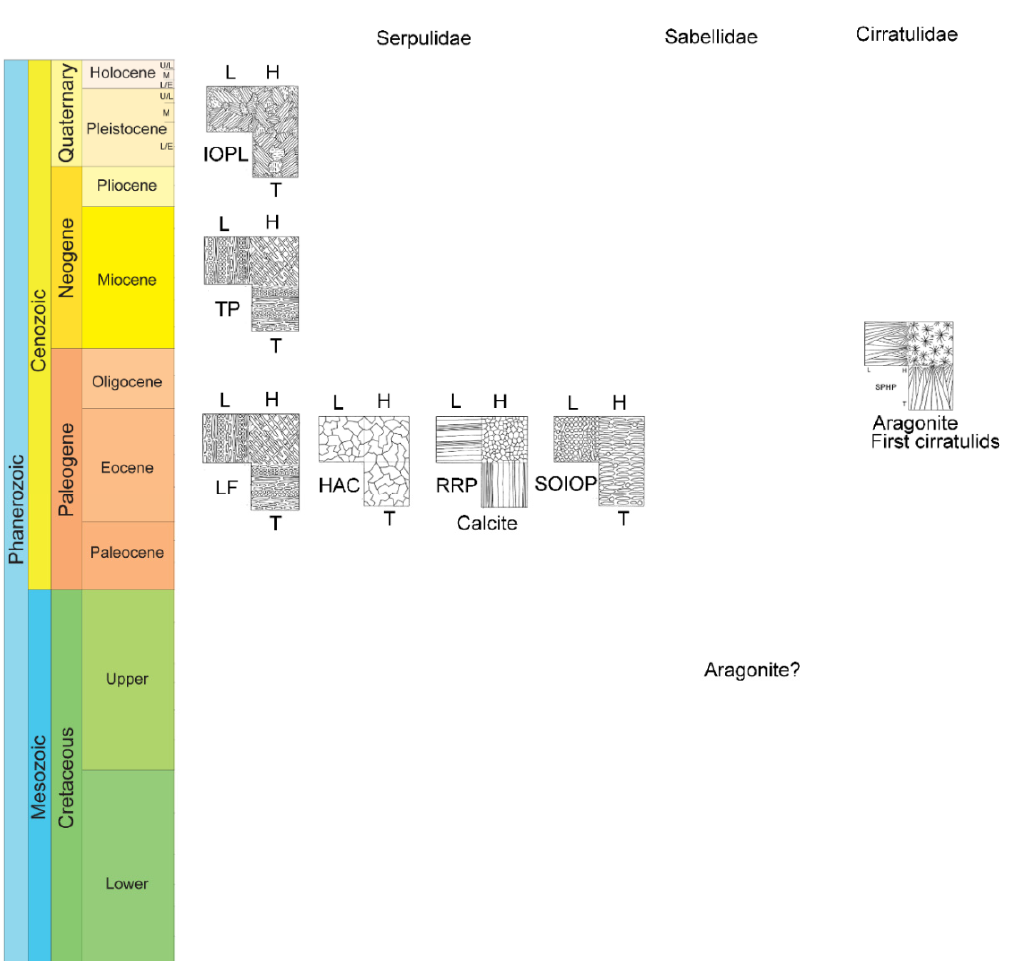
Figure 3. First appearances of tube microstructures and mineral composition in calcareous polychaetes (Permian to Jurassic). IOP—irregularly oriented prismatic structure, SPHP—Spherulitic prismatic structure, SP—simple prismatic structure. Stratigraphy modified based on the International Stratigraphic Chart [28].